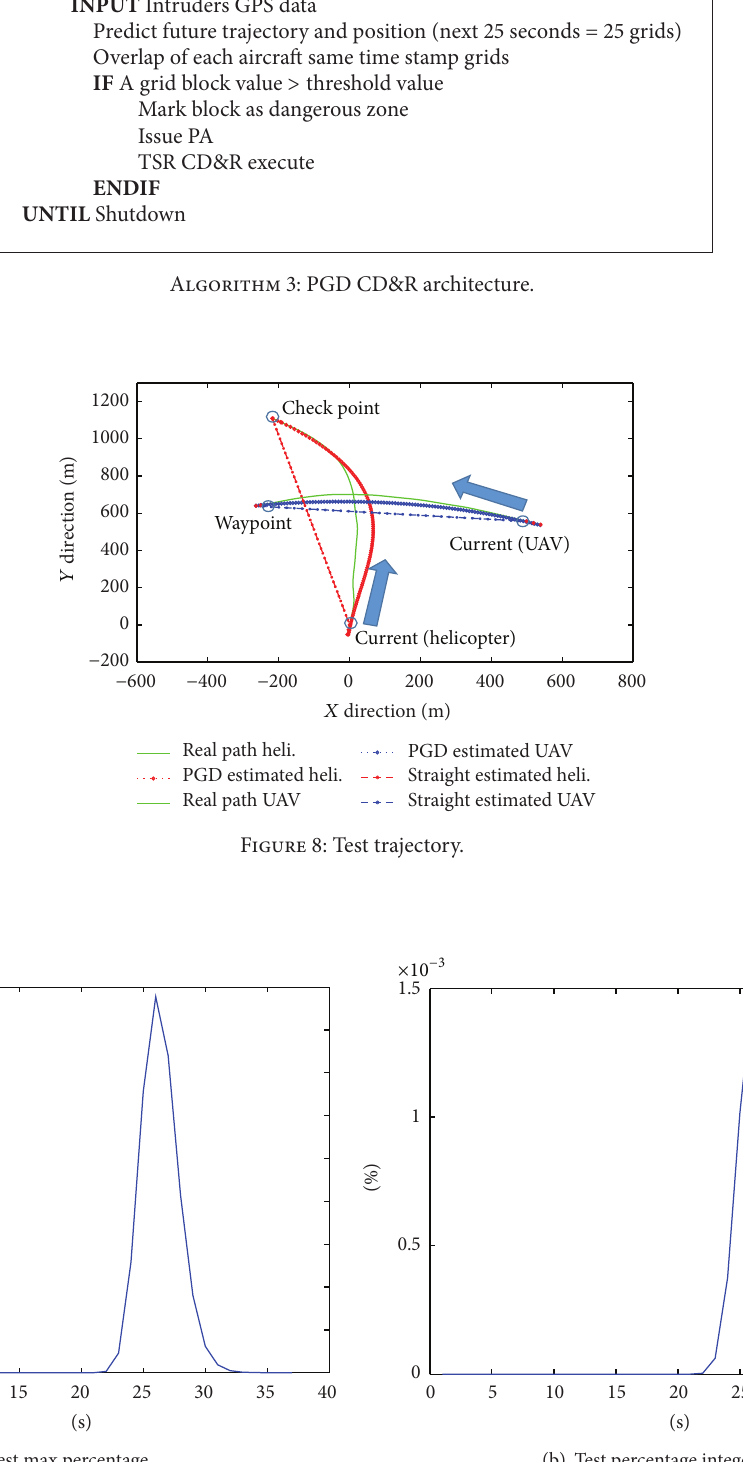
Figure 9: Graph of probability of